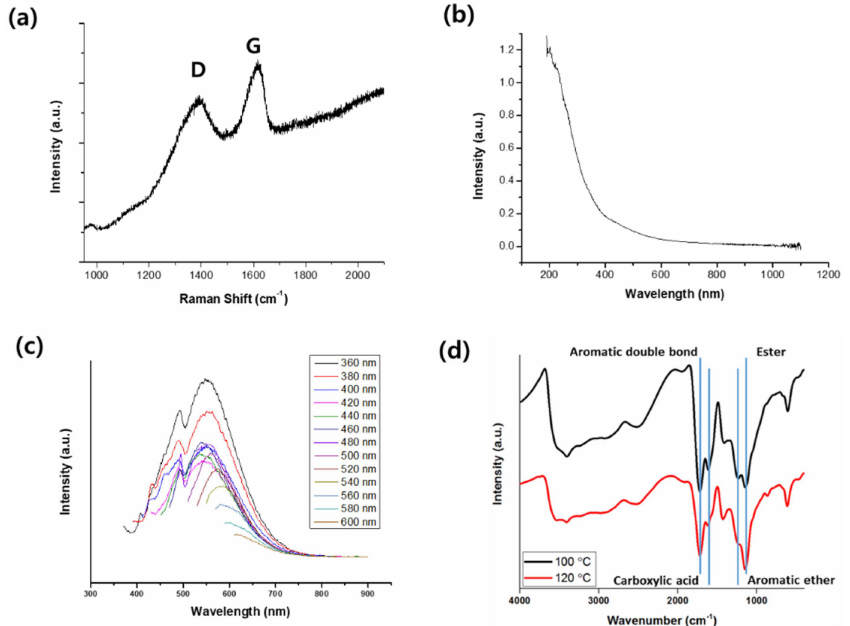
Figure 1. Characterization of graphene quantum dots. ( a ) Raman spectrum and ( b ) UV–Vis–NIR absorbance spectrum of GQD. ( c ) Emission spectra of GQDs with various excitation wavelengths. ( d ) FT–IR spectra of GQDs synthesized at 100 ◦ C and 120 ◦